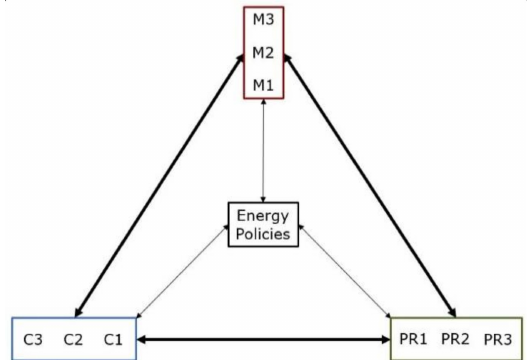
Figure 1. Analytical framework: representation of dimensions and scales of social acceptance. The dimensions are visualized in a triangle, covering the market (m), community (c), and political– regulatory (PR) dimensions. The numbers 1, 2, and 3 represent the macro, meso, and micro (local) scales, respectively (e.g., M3 = local market). The double arrows between each dimension represent the multiple connections between scales, dimensions, and